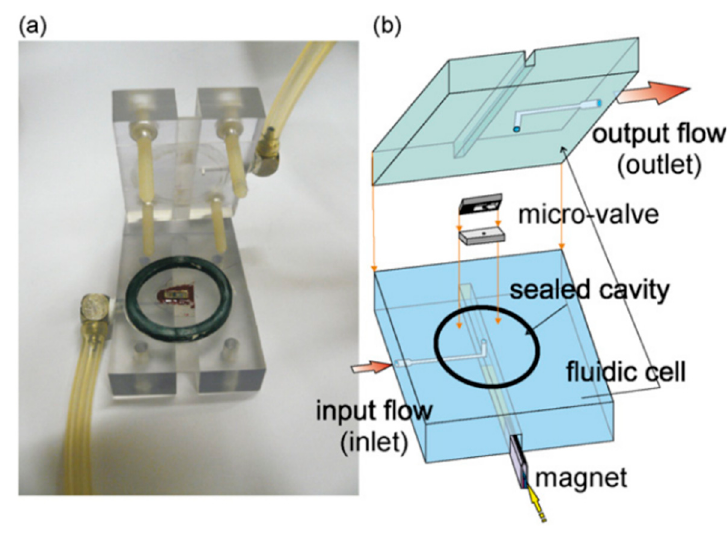
Figure 8. Parts of the magnetic-actuated microvalve and polycarbonate fluidic cell [57]: ( a ) Experimental set-up; ( b ) Schematics of the system.